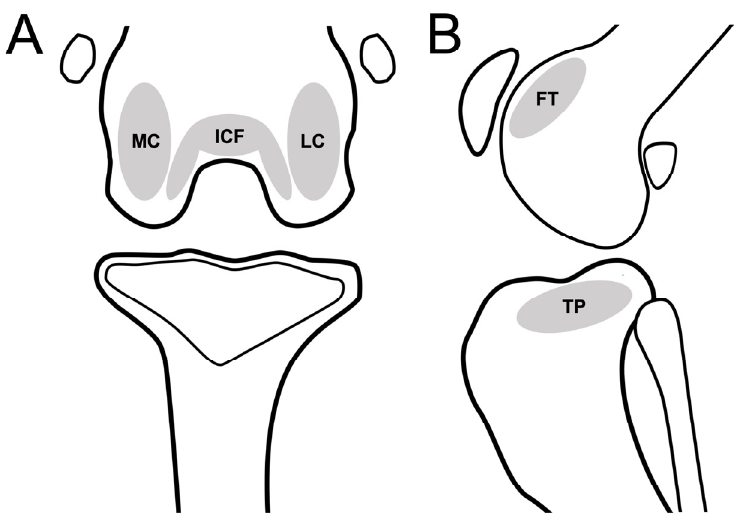
Figure 3. Schematic representation of stifle joint anatomic compartments for evaluating subchondral lesion in the dorsal plane (CT or MRI)/caudocranial view (DR) ( A ), and sagittal plane (CT or MRI)/mediolateral view (DR) of stifle joint ( B ). Stifle joint is divided into 6 subregions to evaluate subchondral lesions. Abbreviations: FT, femoral trochlear; ICF, femoral intercondylar fossa; LC, femoral lateral condyle; MC, femoral medial condyle; TP, tibia